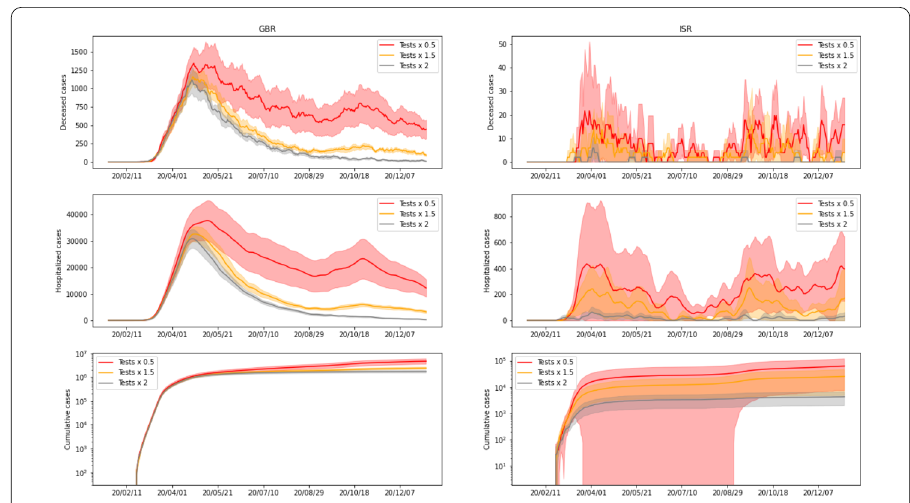
Figure 12 Scenario8 . Comparison of simulations with different number of tests performed, without alterations on tracing and testing policies. The factor for each case is applied to the real number of daily tests. We present cumulative cases, hospitalized and deceased for both GBR (on the left) and ISR (on the right)